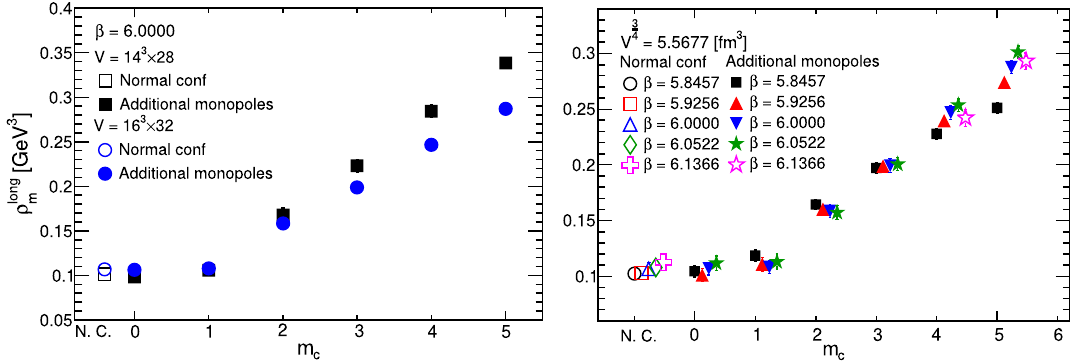
3 = 5 . 5677 [fm 3 ] with the 4 of three-dimensional physical volume V phys resultsofthestandardconfigurations. Thesymbolsintherightpanelare slightly shifted along the horizontal axis to show the difference clearly